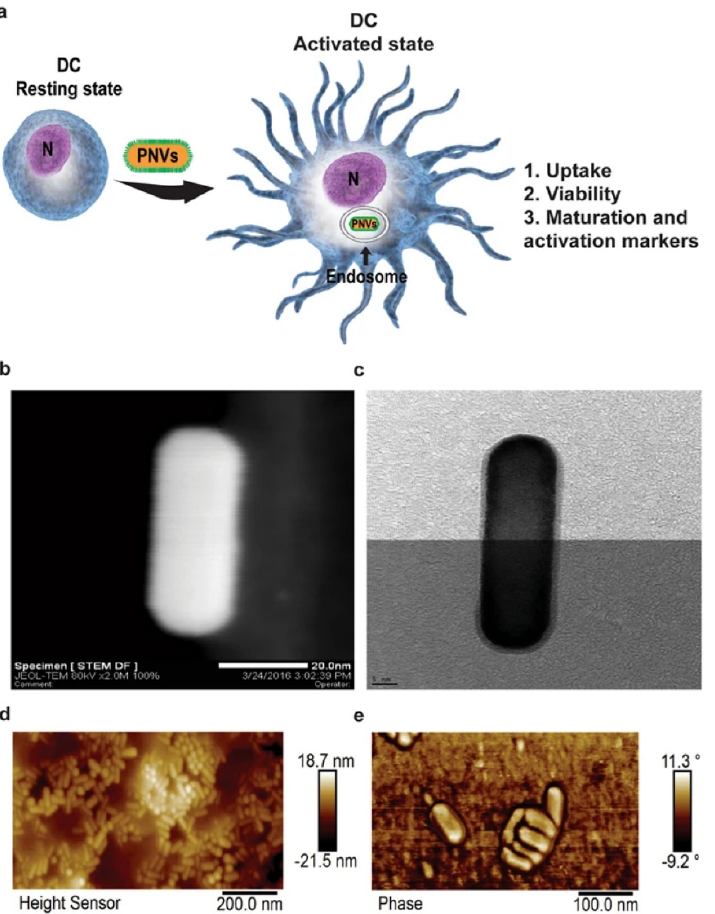
Figure 7. ( a ) Schematic diagram of a plasmonic nanovector (PNV) inducing DC maturation. Three factors, including PNV uptake, viability, and PNV-mediated DC activation marker upregulation, aid in the conversion of resting DCs into activated DCs. N indicates nucleus. ( b ) STEM and ( c ) TEM image of PNV. AFM image ( d ) left side and ( e ) right side of PNV. Reproduced from Vang et al. [94] which is licensed under a Creative Commons Attribution-(CC BY 4.0) International Li-